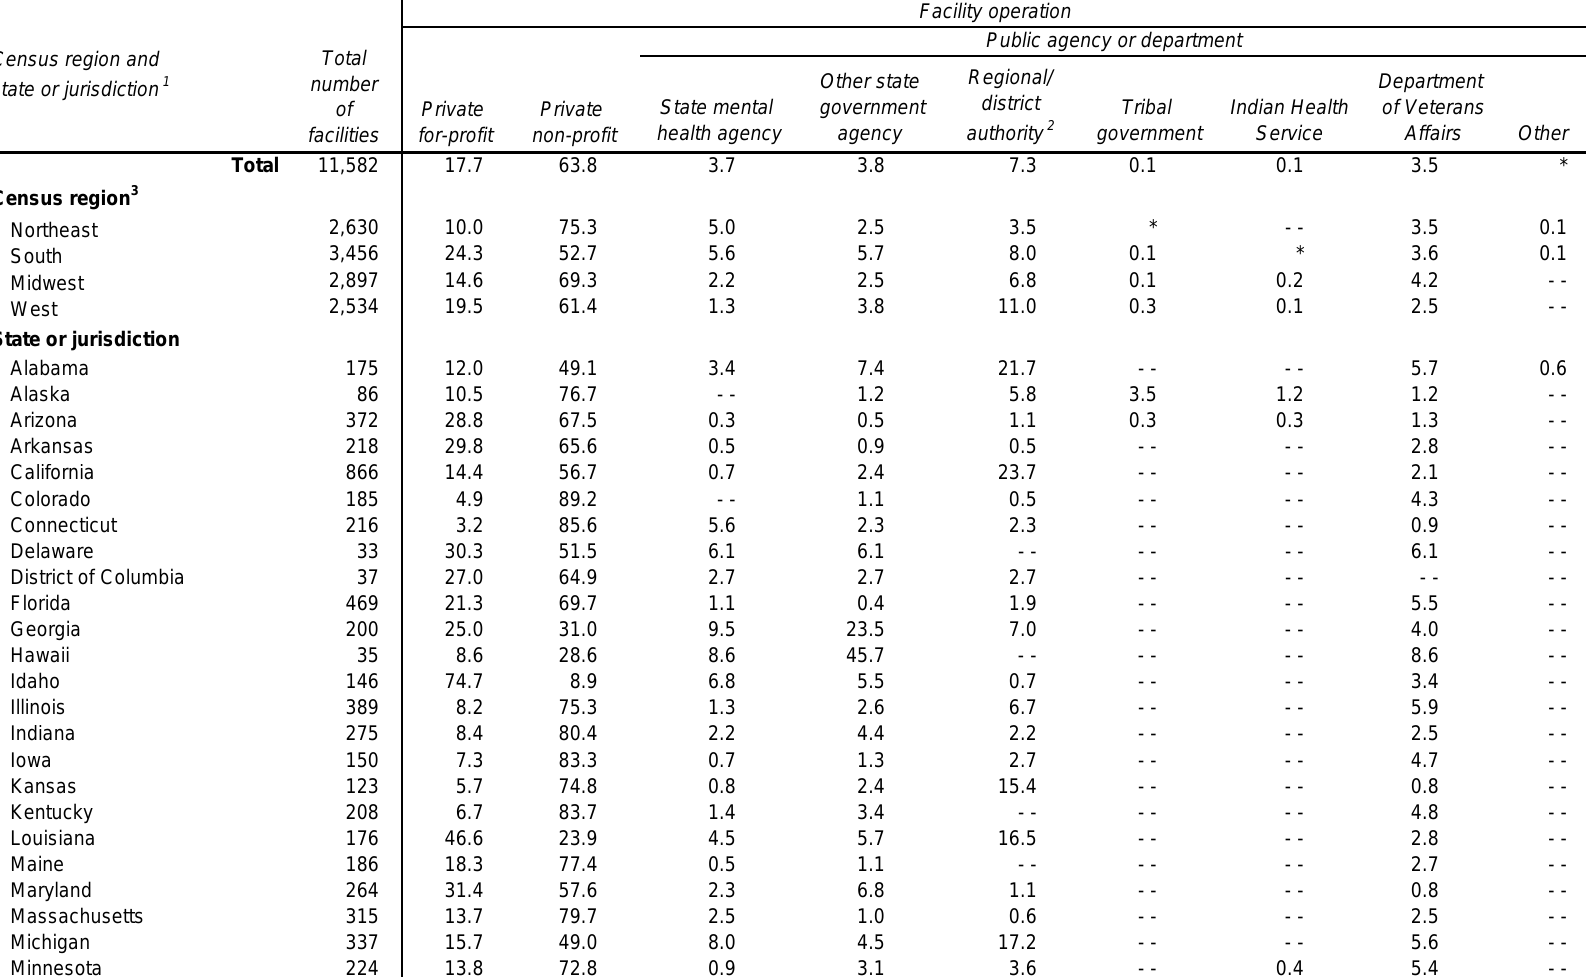
Table 3.2b. Mental health treatment facilities, by facility operation, Census region, and state or jurisdiction: Percent,